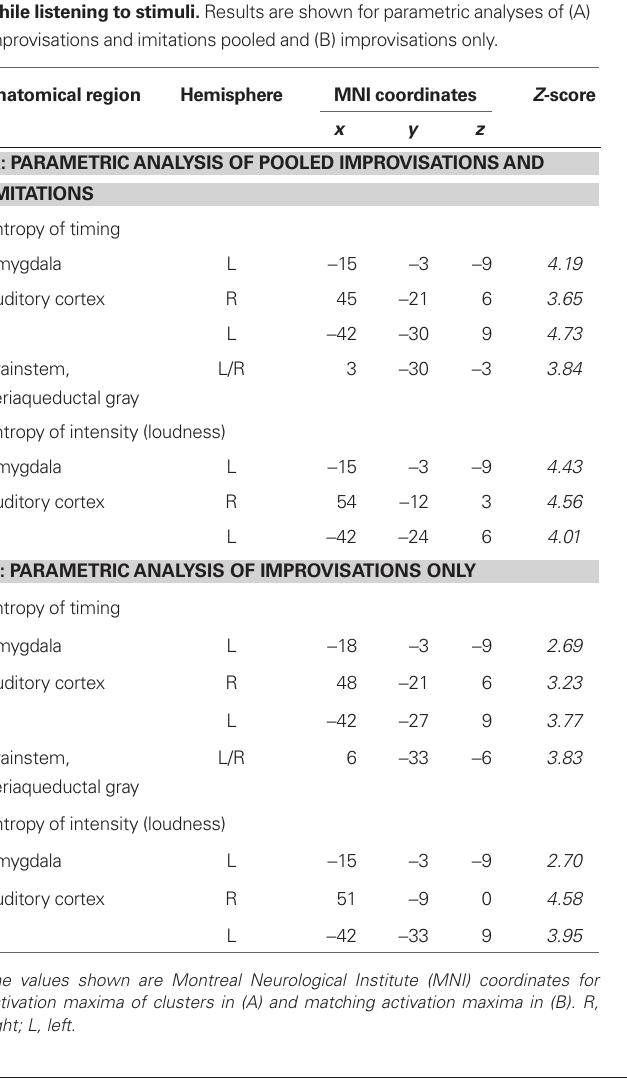
entropy of intensity. The statistical parametric map (SPM) is overlaid on a probabilistic anatomical map based on histological analyses of 10 post-mortem human brains (Amunts et al., 2005; www.fz-juelich.de/ime/spm_anatomy_ toolbox) and thresholded at P < 0.001, uncorrected. The color bar indicates t statistic values.